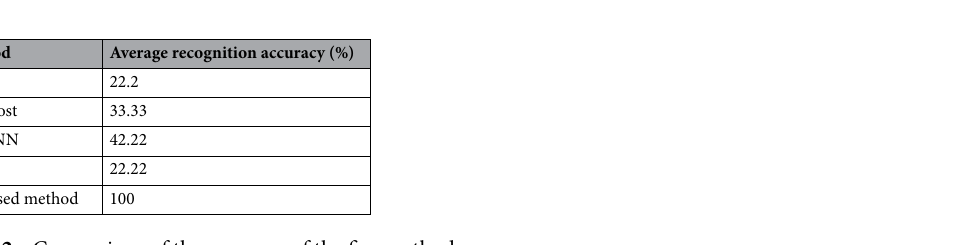
Figure 10. Precision comparison.